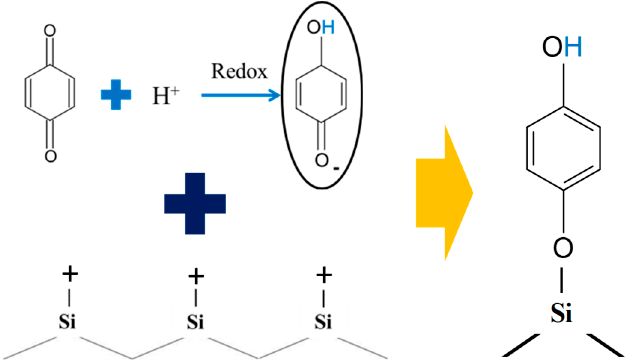
Figure 5. Schematic illustration for Si–SQ formation.